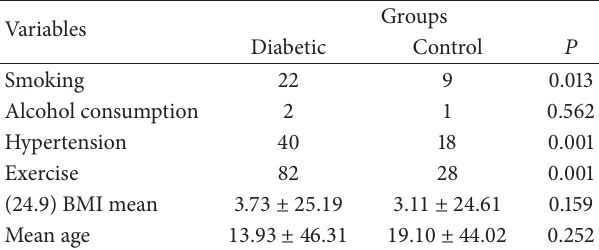
Table 2: Frequency of related variables in diabetic patients and of the nondiabetic controls.